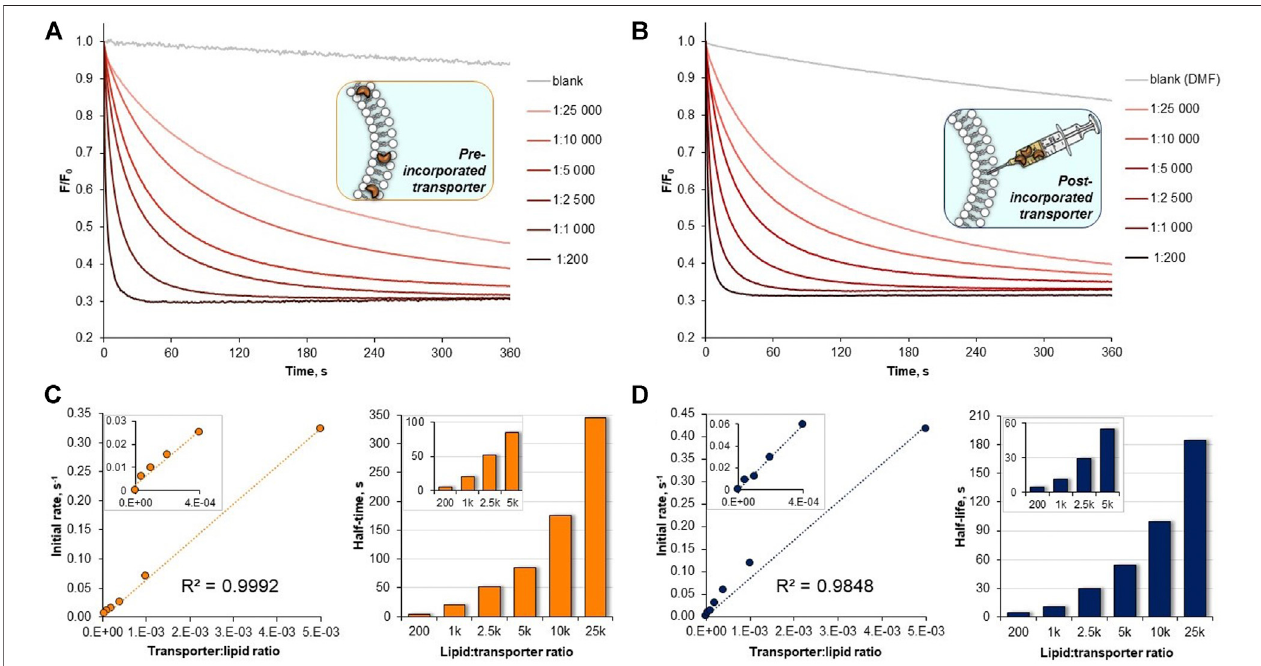
FIGURE 5 | (A) Raw data from the chloride transport studies by 10 (A) pre-incorporated in the membrane, (B) post-incorporated in the membrane. Plots of initial rates Ivs transporter:lipidratiofor 10 andcorrespondingresultsfromhalf-lifetimes t 1/2 calculations: (C) pre-incorporatedanionophore, (D) anionophoreaddedexternally as a solution in